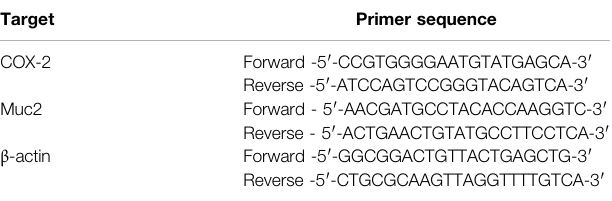
TABLE 2 | Colon tissues Real-time PCR